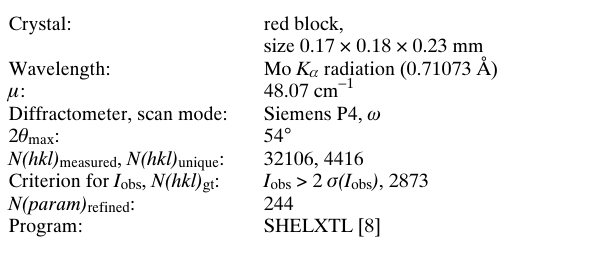
Table 1. Data collection and handling.